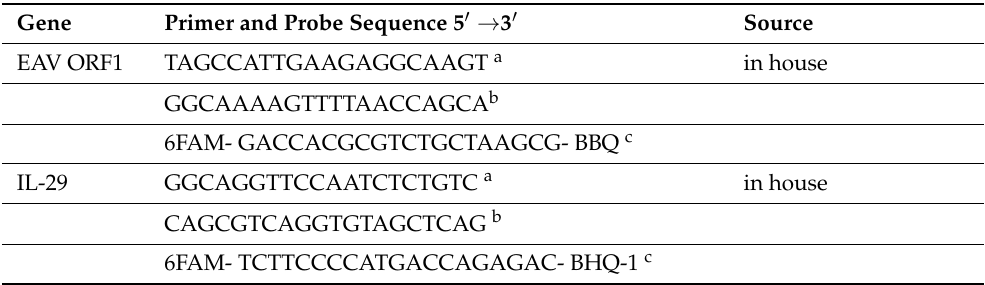
Table 1. Primer and probe sequences